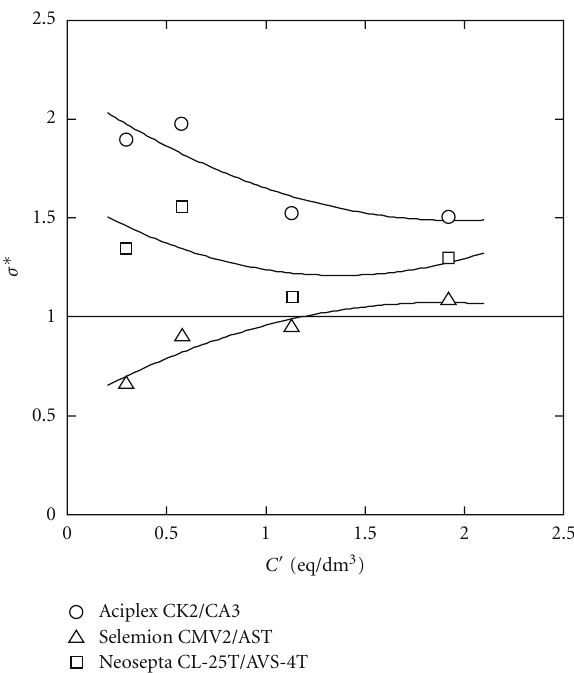
Figure 14: Relationship between salt concentration in a feeding solution and overfull concentration reflection coe ffi cient.